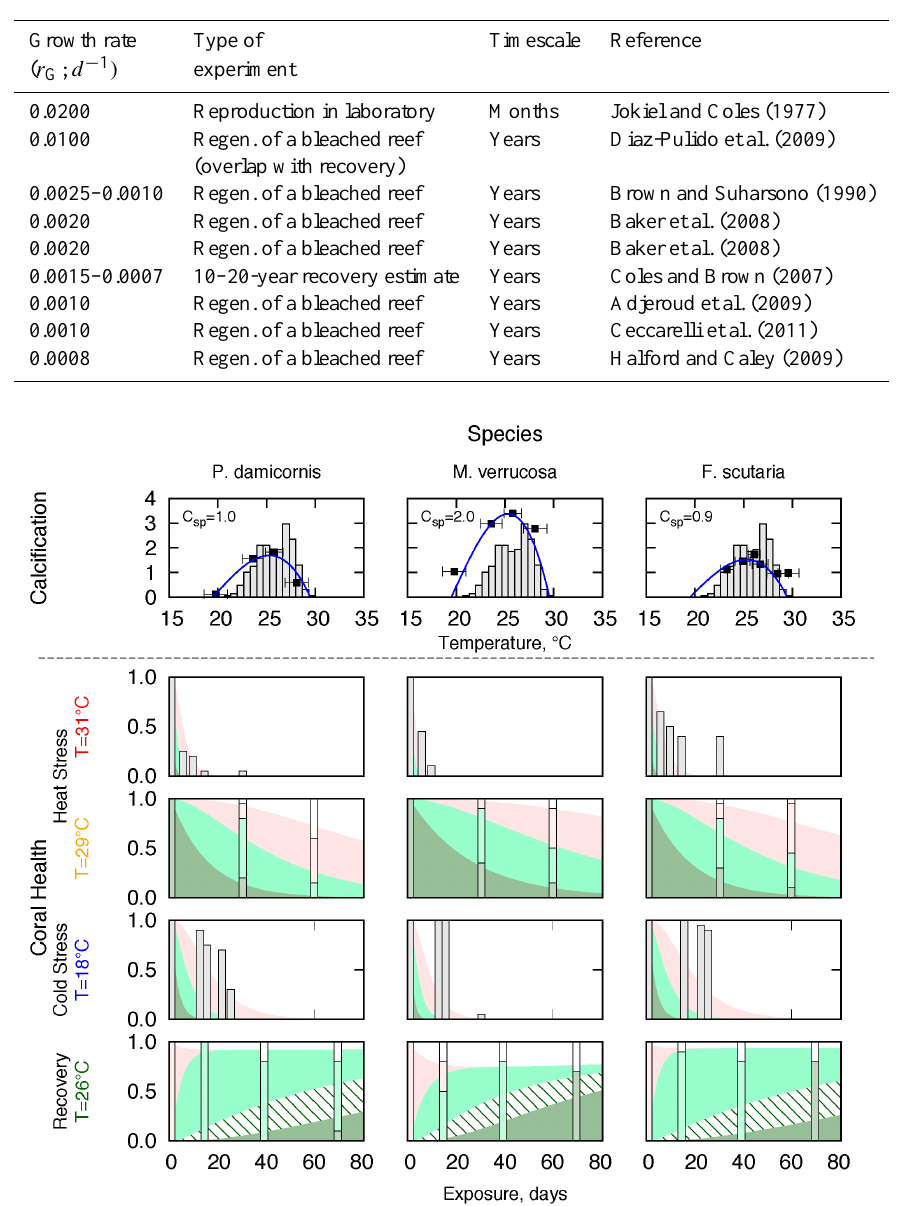
Table 2. Estimated growth constants for the corals after bleaching